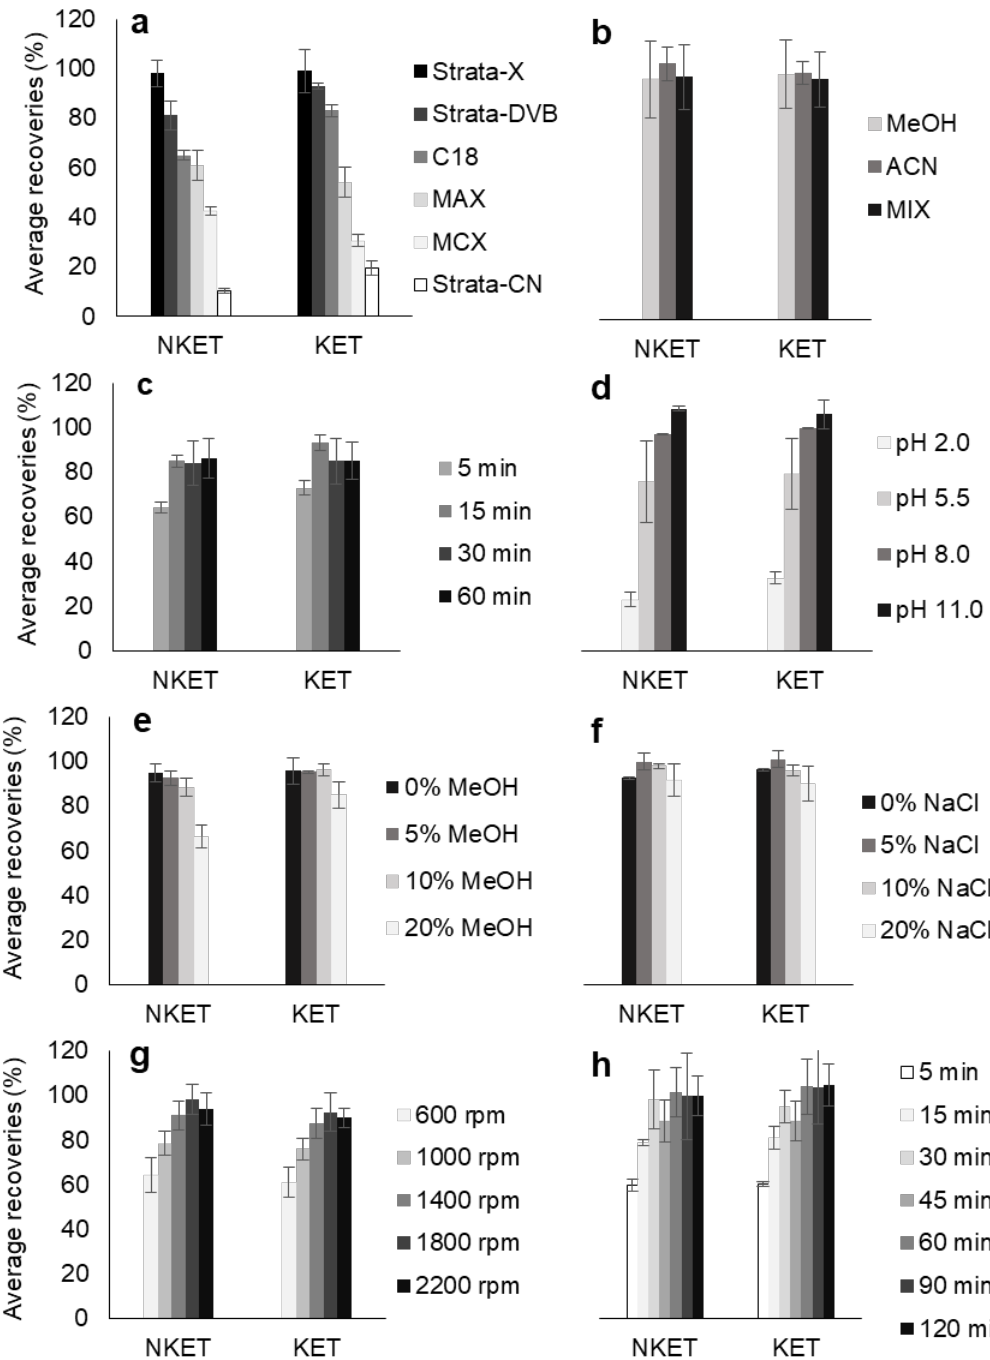
Figure 1. E ff ect of polymeric sorbent selectivity ( a ), microliquid desorption ( µ LD) solvent ( b ) and µ LD time ( c ), matrix pH ( d ), polarity ( e ) and ionic strength ( f ), as well as shaking speed ( g ) and microextraction time ( h ) on the enrichment of ketamine (KET) and norketamine (NKET) from aqueous media, obtained by high-throughput bar adsorptive microextraction (HT-BA µ E)- µ LD / large volume injection-gas chromatography-mass spectrometry operating in the selected ion monitoring mode (LVI-GC-MS(SIM)). The error bars represent the standard deviation for the recovery levels of three replicates for each parameter evaluated. The microextraction devices were designed to be used only one time, once they are inexpensive and in order to avoid carryover e ff ects